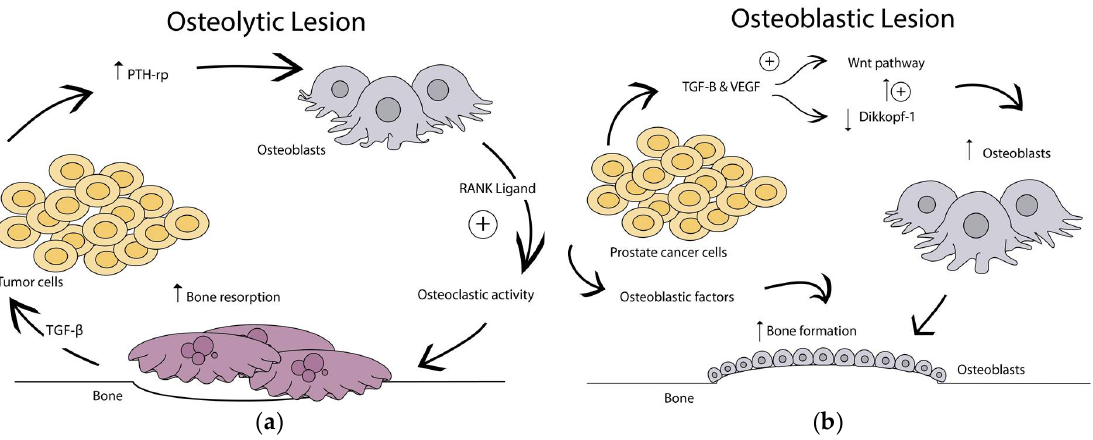
Figure 1. Bone metastatic lesions can be either osteolytic or osteoblastic. ( a ) Osteolytic lesions are caused by overactivation of osteoclast bone resorption; ( b ) Osteoblastic lesions result from direct tumor stimulation of osteoblasts. PTH-rp: parathyroid hormone-related peptide; RANK: receptor activator of nuclear factor-kappa B; TGF-β: Transforming growth factor-β.